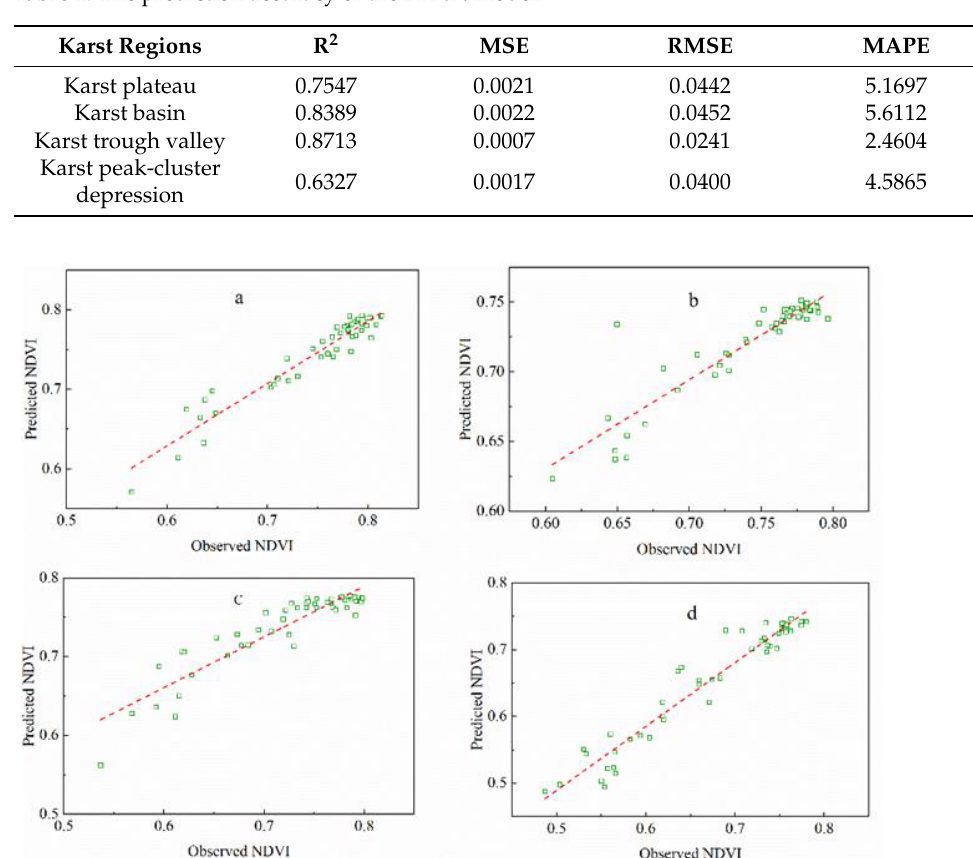
Figure 3. Comparison of the observed and BPNN predicted NDVI in the ( a ) karst trough valley, ( b ) karst peak-cluster depression, ( c ) karst plateau, and ( d ) karst basin. Table 1. The prediction accuracy of the BPNN model.